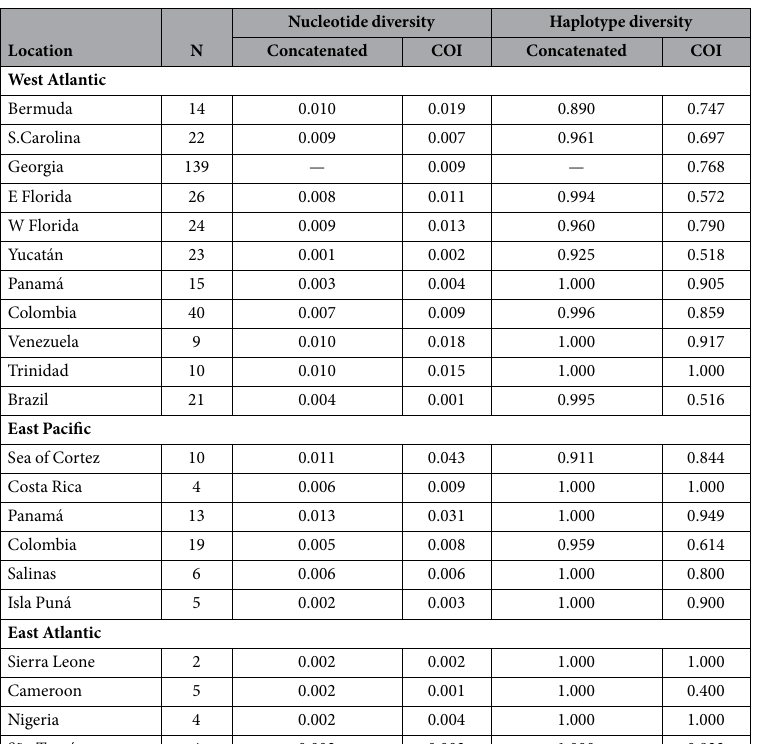
Table 3. Nucleotide and haplotype diversity 107 based on Tamura and Nei 109 distances in sampled populations of Petrolisthes armatus . Concatenated data are composed of a partial sequence of 16S and COI-af and COI-HL. COI data are limited to COI-HL